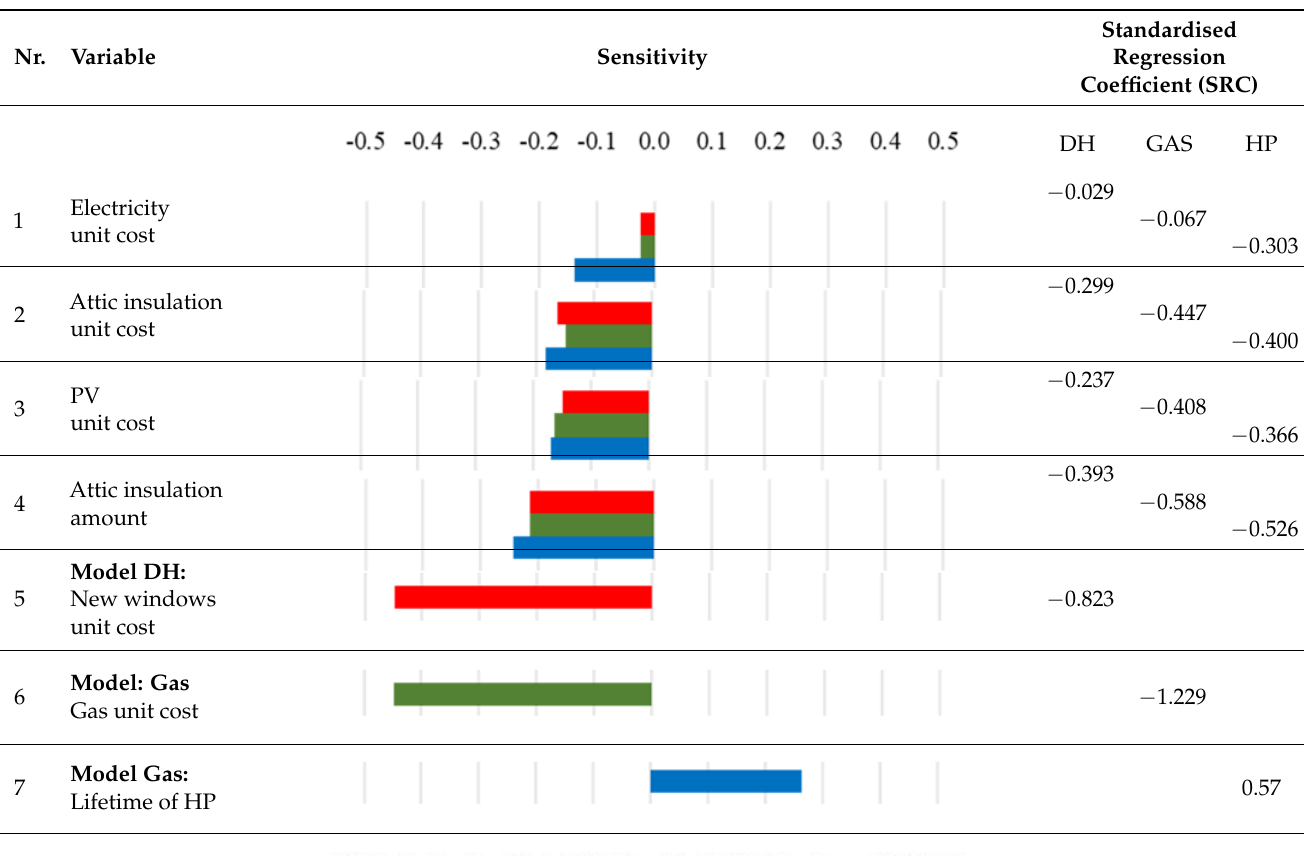
Table 4. Summary of linear regression results for the three investigated space ‐ and DHW heating systems.